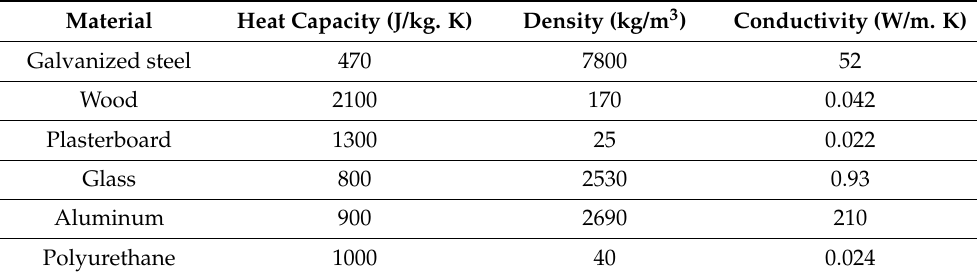
Figure 2. EEBLab test sites with an Earth-to-air heat exchanger prototype, electric vehicle, different types of PV panels, weather station, and wind turbine. Table 1. Thermal properties of the EEBLab construction materials.